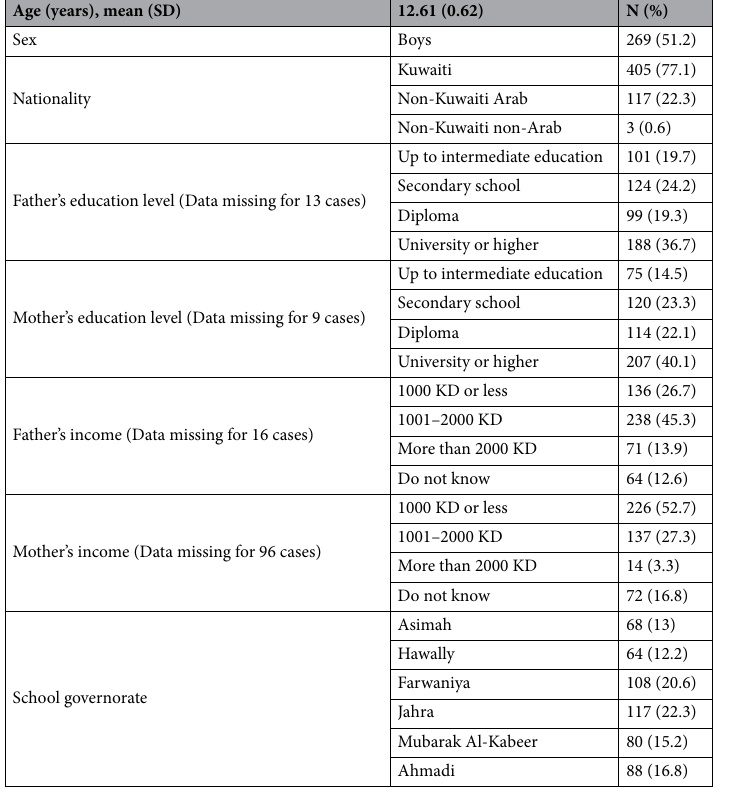
Table 1. Sociodemographic characteristics of the study subjects (N =